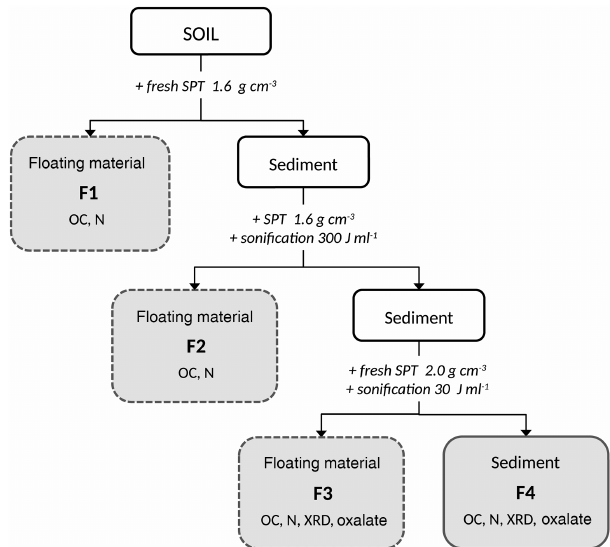
Figure 1. Sequential density fractionation scheme. SPT: sodium- polytungstate solution, F1: fraction predominately organic matter of densities <1.6gcm − 3 with basically no interaction with the min- eral phase, F2: fraction predominately organic matter of densities <1.6gcm − 3 and weakly associated with the mineral phase, F3: soil materials of densities between 1.6 and 2.0gcm − 3 and holding or- ganic matter strongly bound to mineral phases, F4: soil materials of densities >2.0gcm − 3 and holding organic matter strongly bound to mineral phases. Below the fraction labeling, subsequent analyses are listed. OC: total organic carbon concentration, N: nitrogen con- centration, XRD: X-ray diffraction, Oxalate: